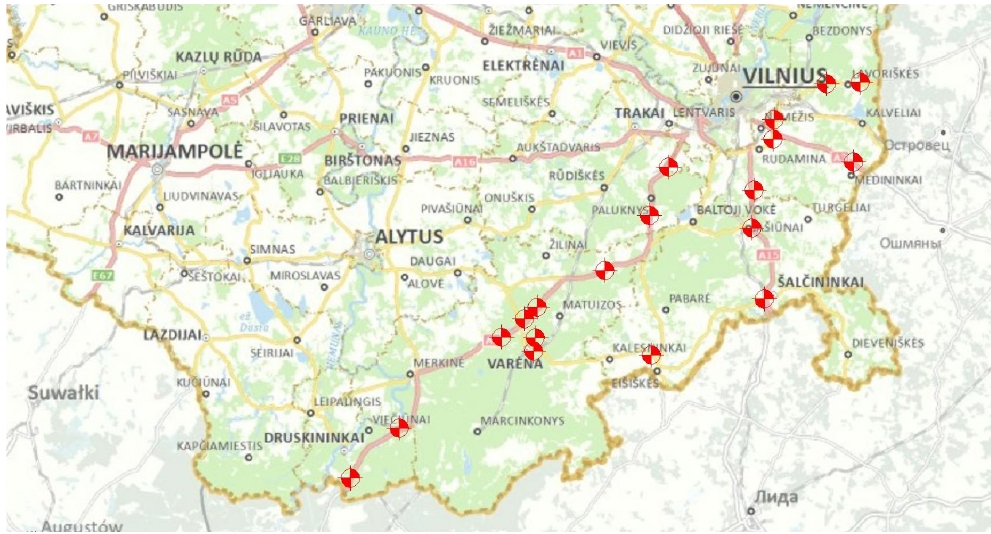
Figure 2. An alternative for the layout of rest areas in